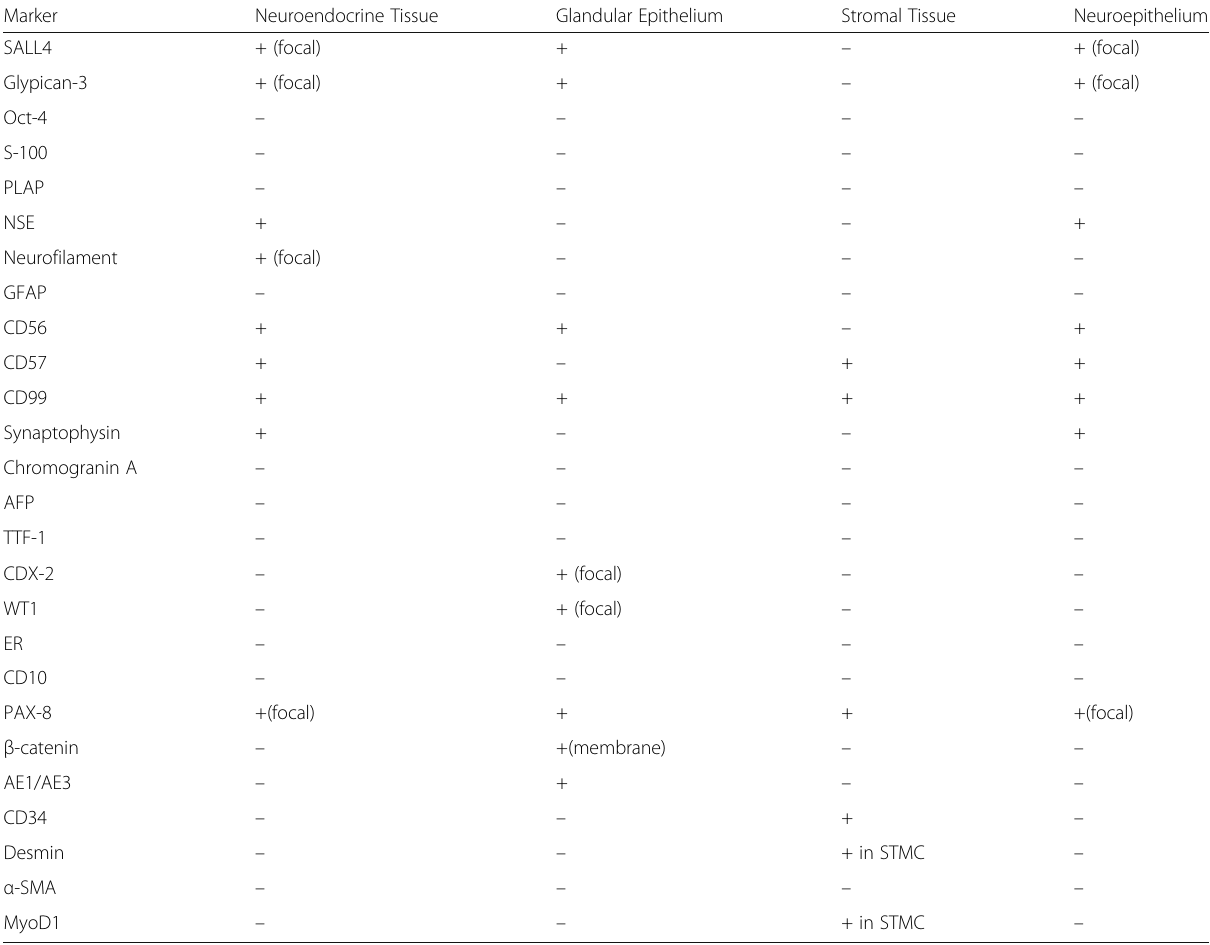
Table 1 Immunohistochemical profile of each component